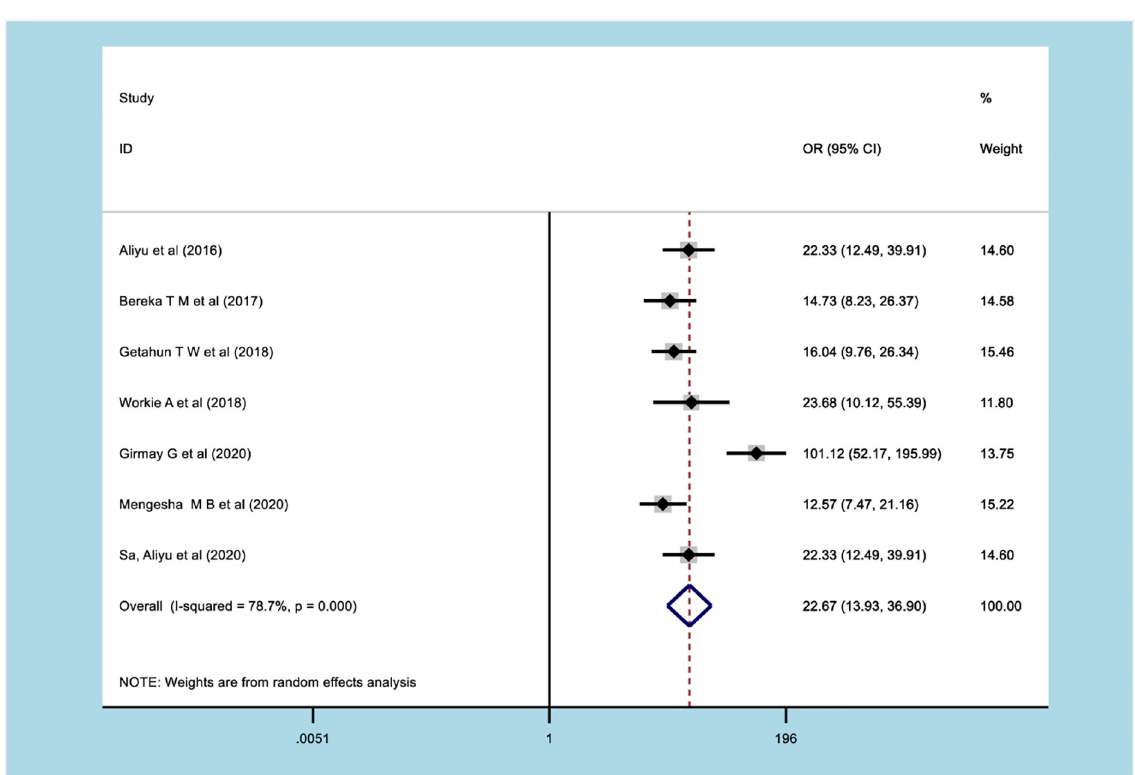
Fig 7. Forest plot of association of obstructed labor with uterine